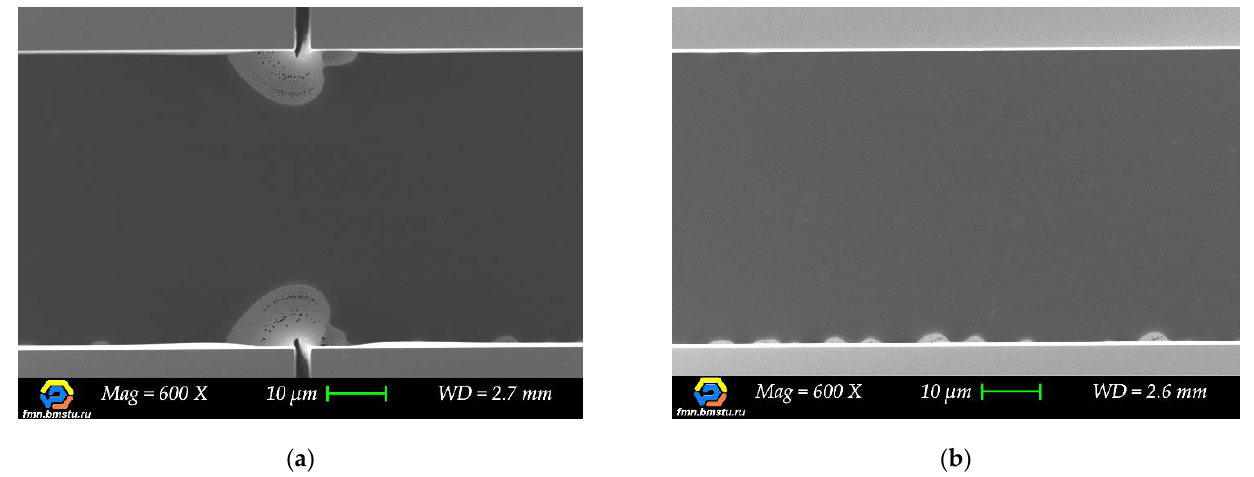
Figure 14. Top view SEM images of the intersection area: ( a ) Transverse crossing auxiliary lines; ( b ) Dashed auxiliary lines.